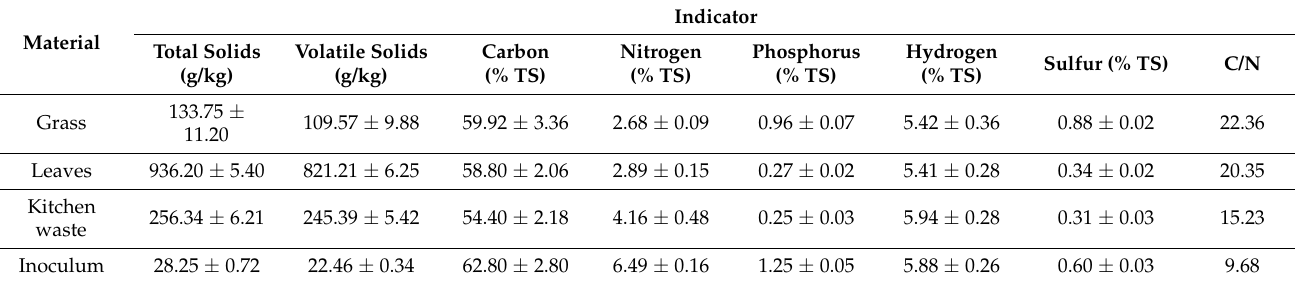
Table 1. Characteristics of materials used in the